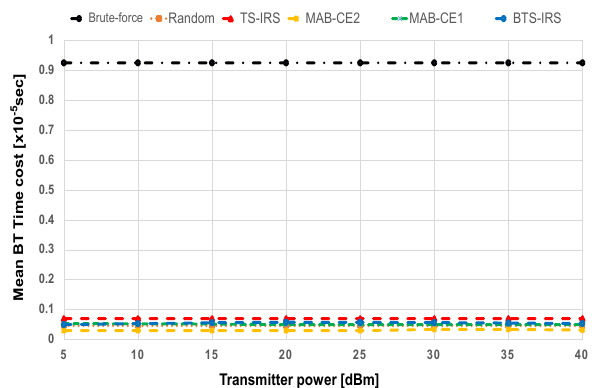
Figure 5. Mean BT time cost versus transmitter power